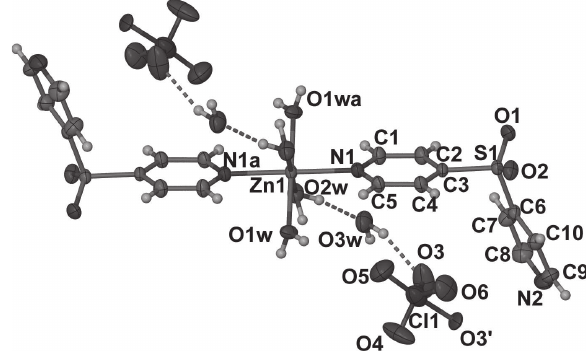
Table 1: Data collection and handling.